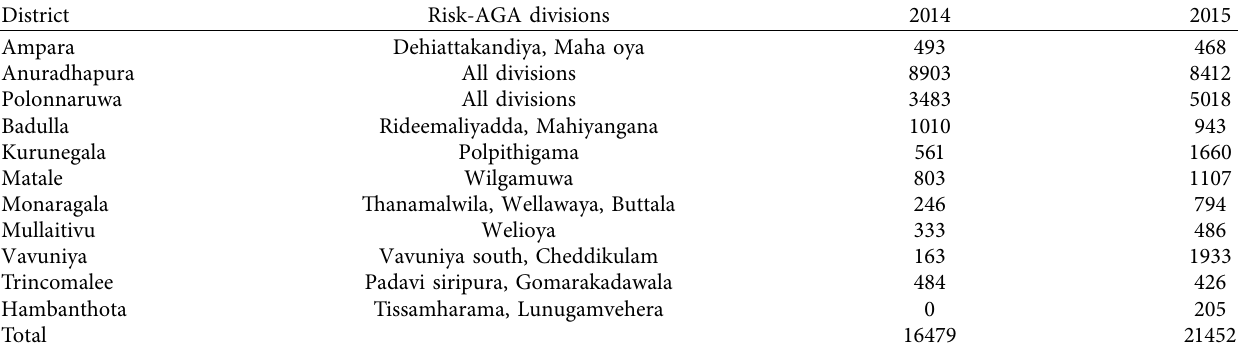
Table 1: CKDu patients in high-risk areas for chronic kidney disease of unknown etiology (CKDu) in Sri Lanka.